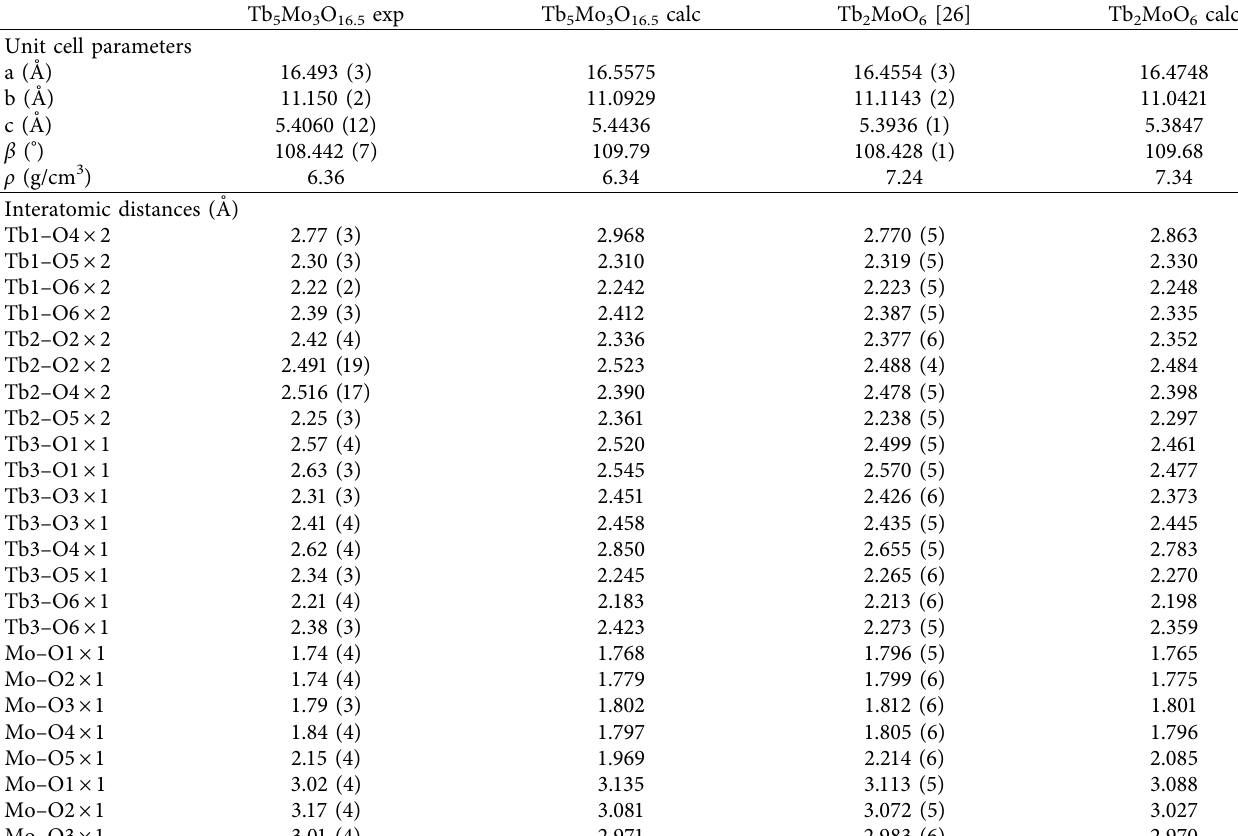
Table 7: Experimental and calculated parameters of monoclinic terbium molybdate crystal structure.